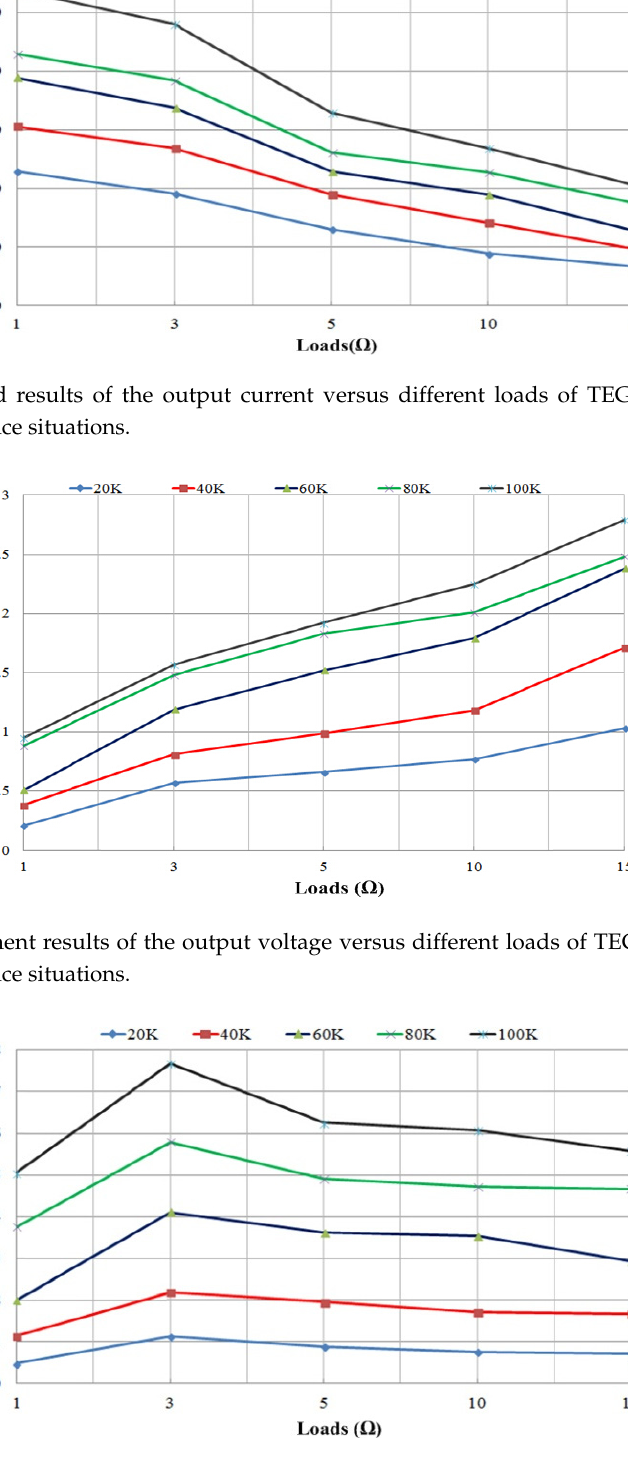
Figure 6. Measured results of the output power versus different loads of TEG module in five temperature difference situations.